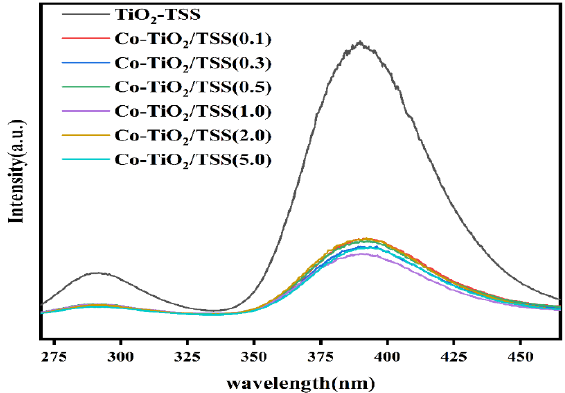
Figure 9. PL spectra of TiO 2 -TSS and Co-TiO 2 /TSS(X).